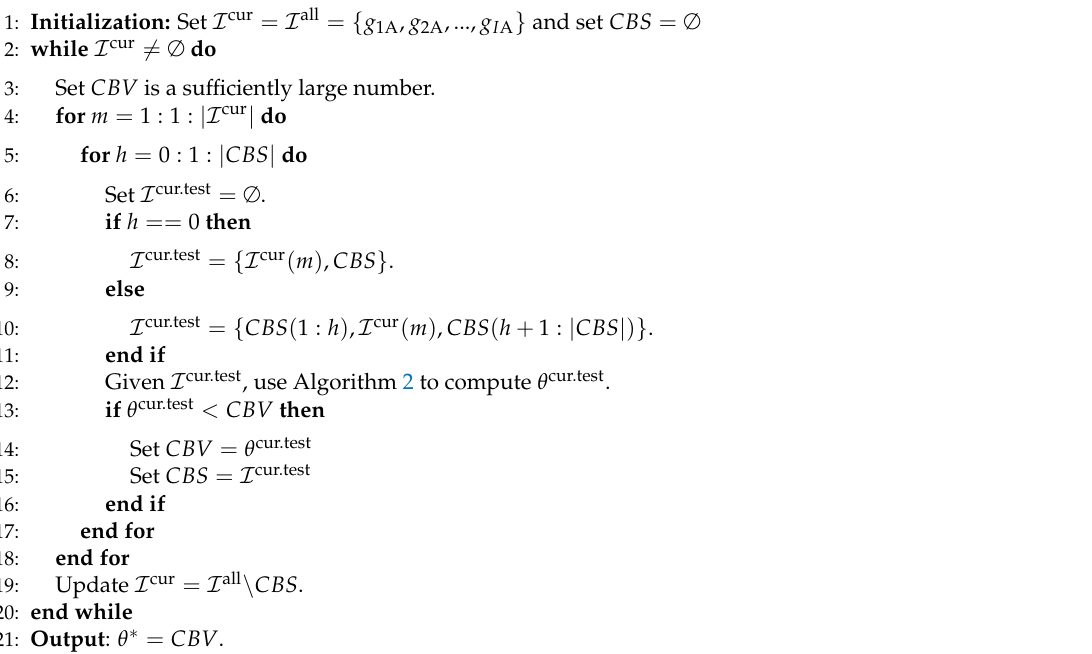
Algorithm 3 To find the optimal